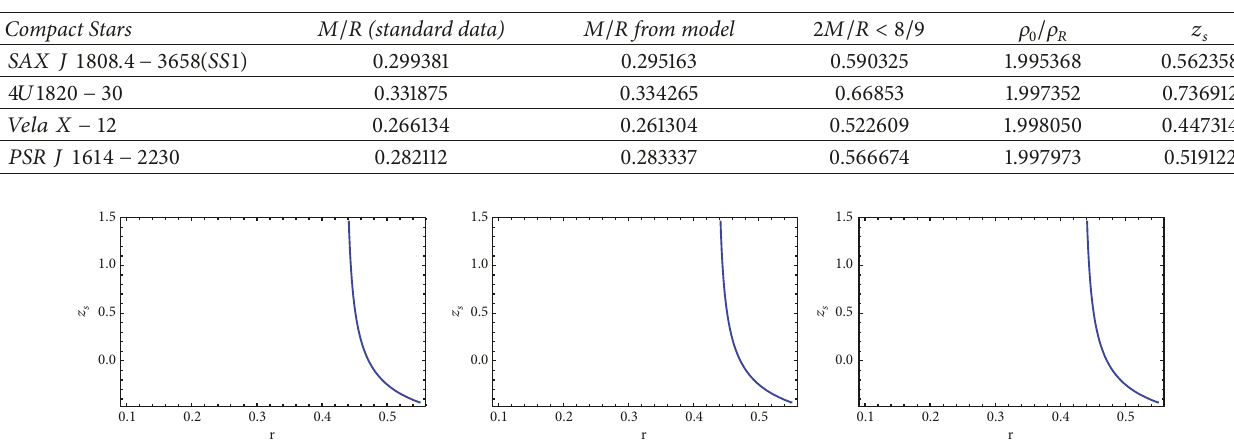
Table 3: Calculated values of the desired parameters of our model.